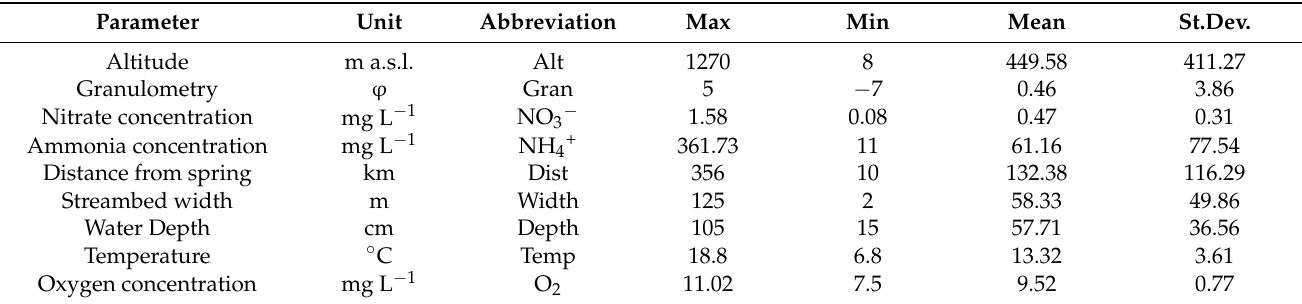
Table 2. Environmental parameters and related units measured in the river Adige network. Maximum, minimum, mean and standard deviation values are reported. Please, note that granulometry size is expressed using a logarithmic scale ( ϕ